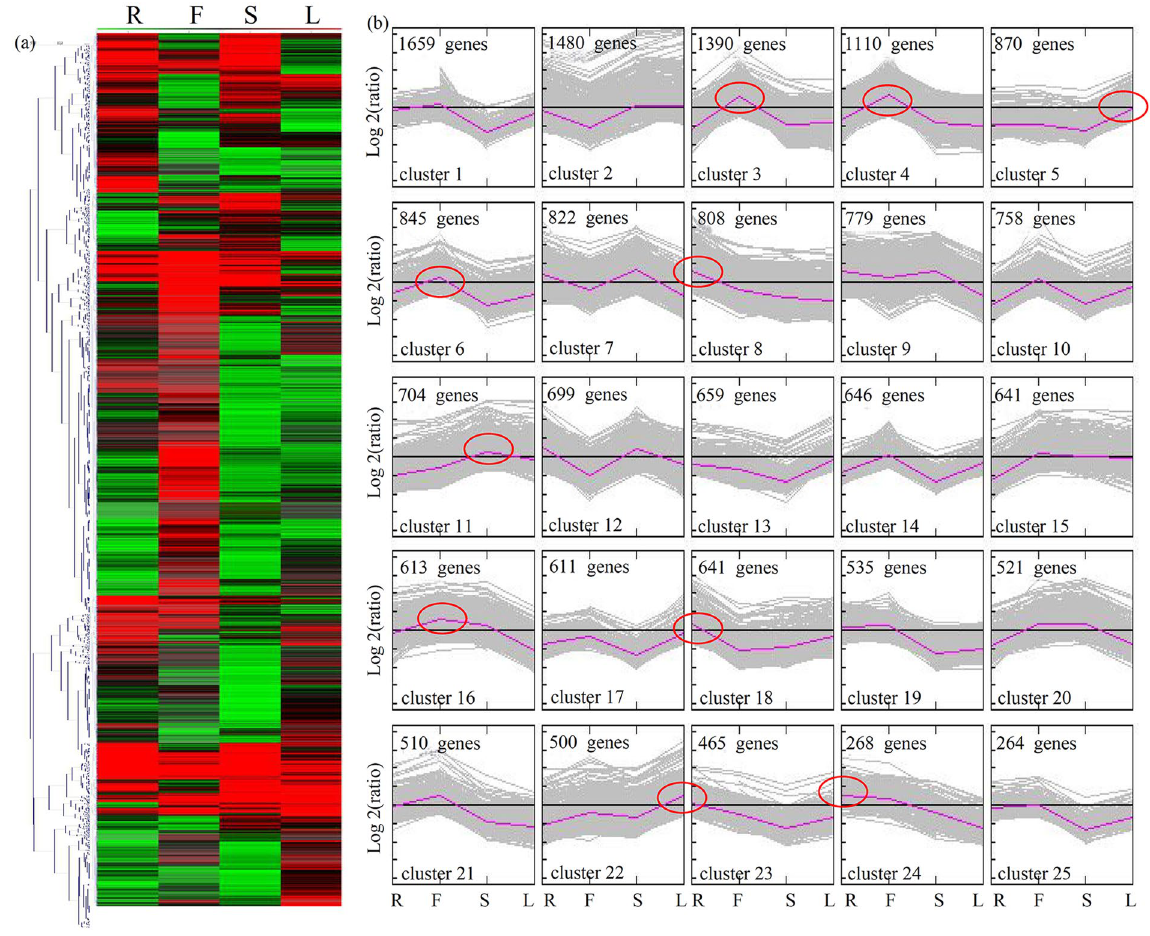
Figure 2. MeV cluster analysis of organ-differentially expressed genes. ( a ) Heat map illustrating the expression profiles of the organ-differentially expressed genes. ( b ) Cluster analysis by the K-means method from the gene expression profiles. Red circles indicated the organ-specific expressed